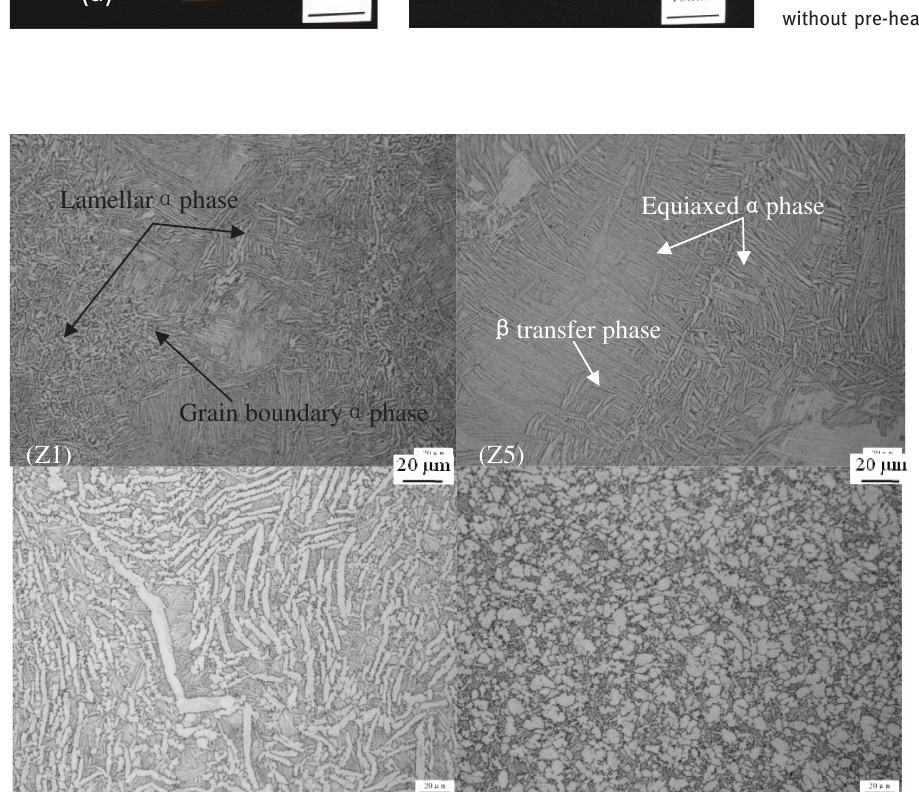
Figure 3: The microstructure of Ti6Al4V rolling bar at tempera- ture of 1010 ℃ (Z1&Z3), 930 ℃